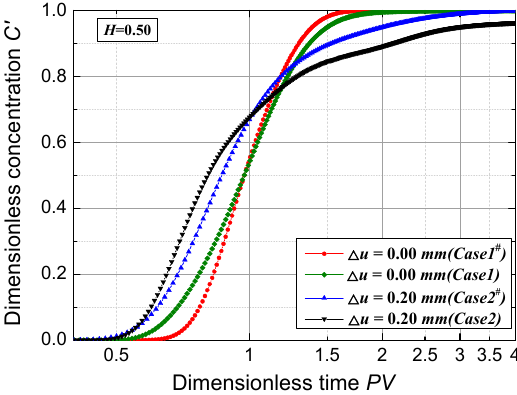
# , Case2, and Case2 #